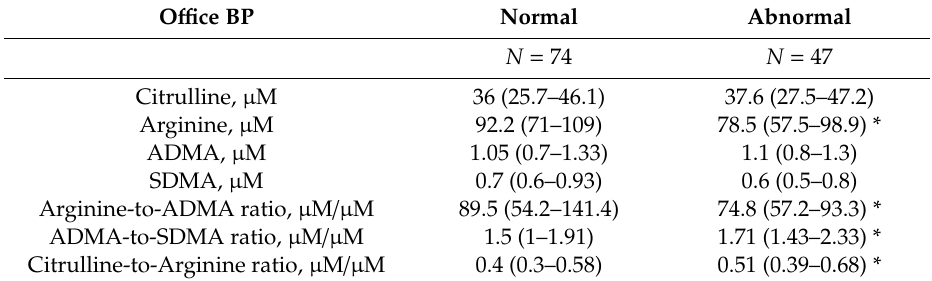
Table 2. Plasma levels of NO pathway components in children and adolescents with CKD.